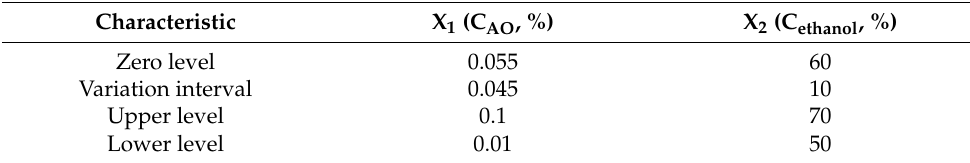
Table 1. Main characteristics of the plan N = 2 2 .